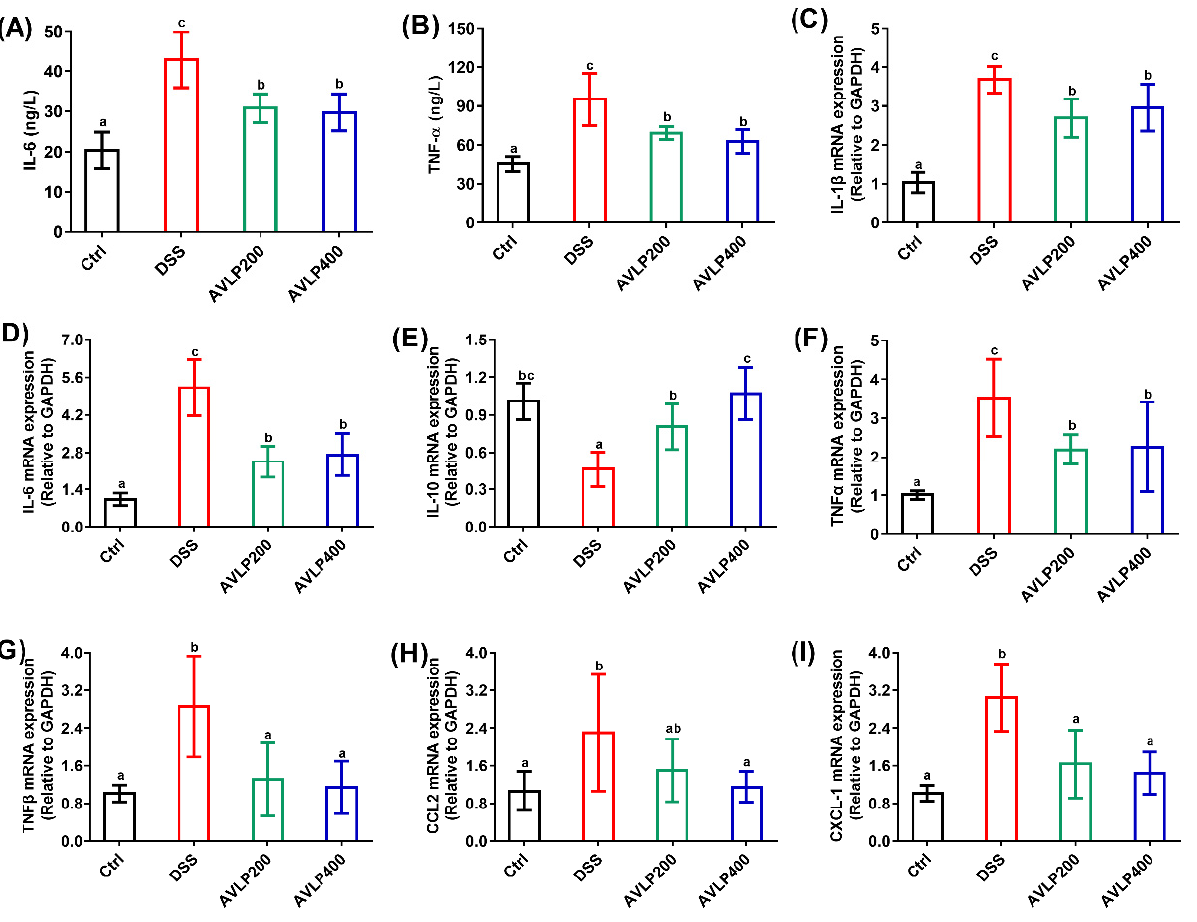
Figure 3. Effects of AVLP on inflammatory cytokines and chemokines in colitis mice. ( A ) Serum IL-6. ( B ) Serum TNF - α . ( C ) IL-1 β mRNA expression. ( D ) IL-6 mRNA expression. ( E ) IL-10 mRNA ex- pression, ( F ) TNF α mRNA expression, ( G ) TNF β mRNA expression, ( H ) CCL2 mRNA expression,